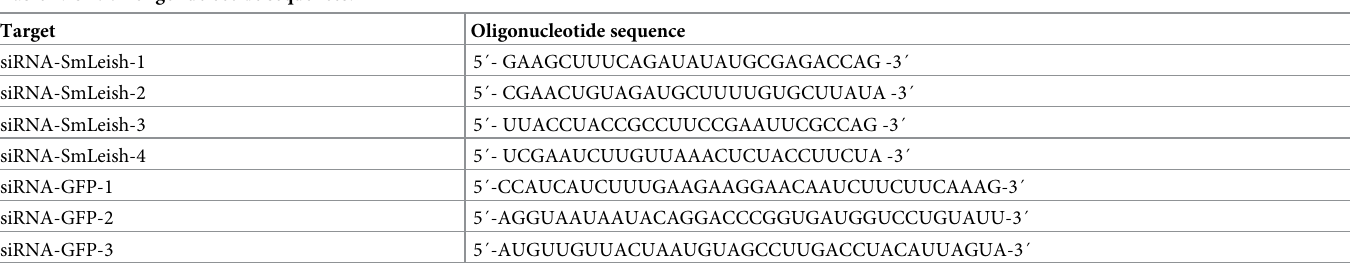
Table 2. siRNA oligonucleotide